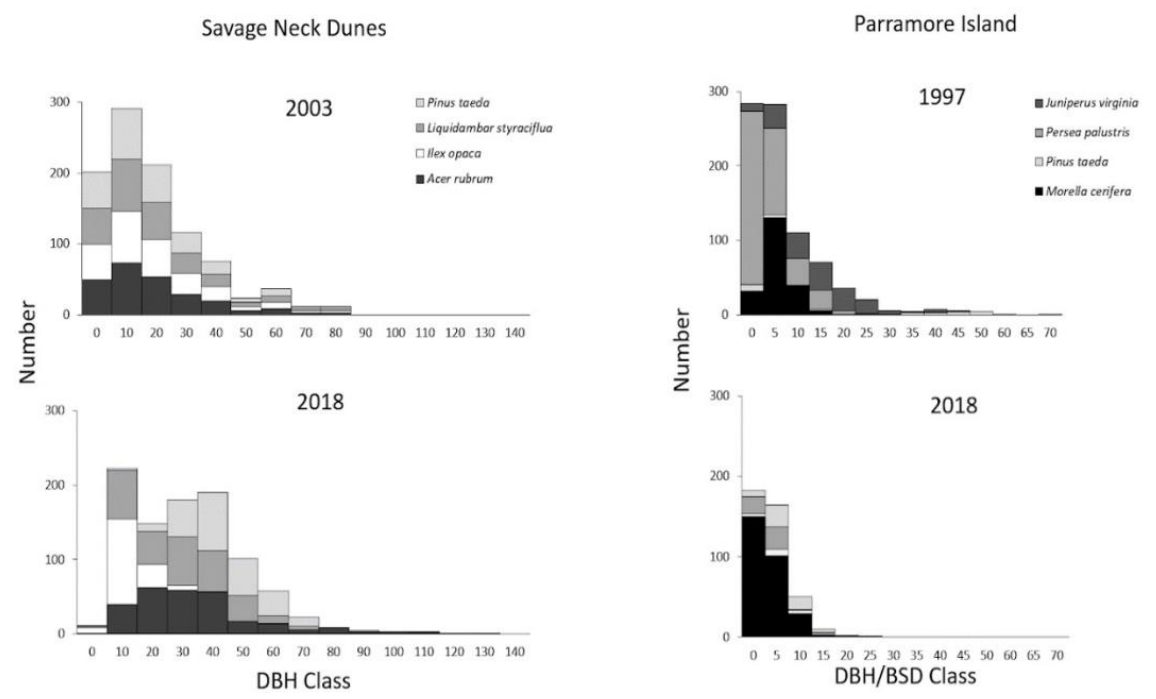
Figure 5. Frequency distributions of diameter at breast height (DBH) or basal area diameter (BSD) size classes for selected species in the maritime forest at Savage Neck between 2003 and 2018, and Parramore Island between 1997 and 2018.